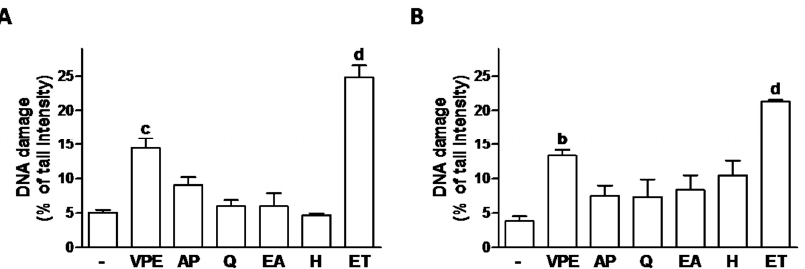
Figure 2. Effect of 48 h exposure to VPE (IC 50 ) and of its major constituents (as present in respective IC 50 s– see Table 3) on DNA damage of HCT116 ( A ) and RKO ( B ) cells, as evaluated by the comet assay. ET (10 μ ) was used as positive control. Values are expressed as mean ± SEM of three independent experiments. Letters represent statistical significance: b p ≤ 0.01, c p ≤ 0.001, d p ≤ 0.0001 when compared with control by one-way ANOVA.